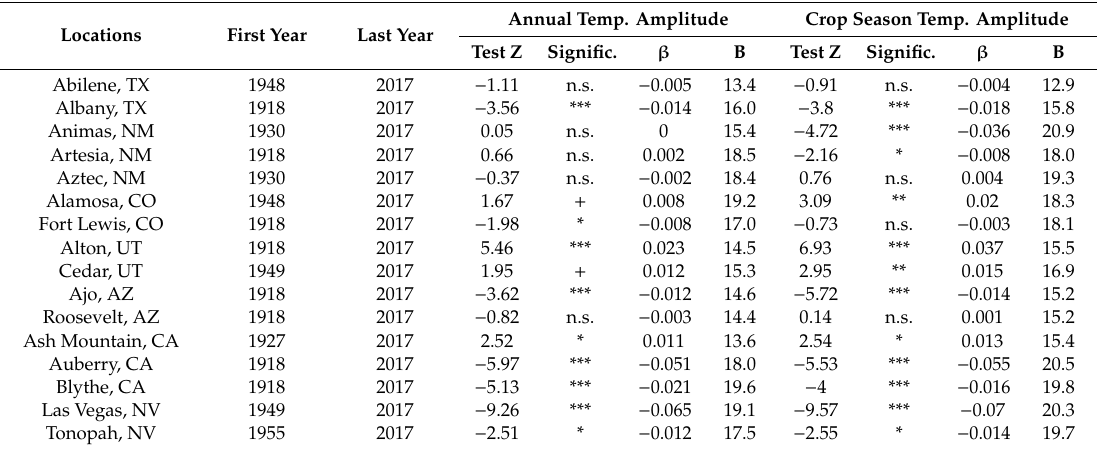
Table 5. Summary of the Mann–Kendall trend test for annual and growing season temperature amplitude.